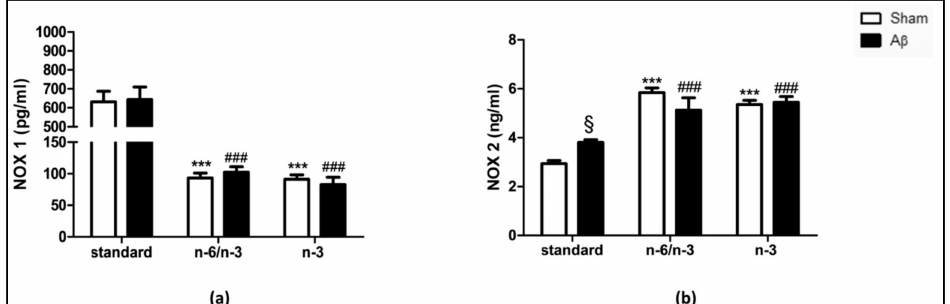
Figure 2. Effects of standard, n-6/n-3 PUFA balanced and n-3 PUFA enriched diets on NADPH oxidases (NOXs) expression in A β -treated rats. Effect of standard, n-6/n-3 PUFA balanced and n-3 PUFA enriched diets on hippocampal NOX1 ( a , SHAM standard n = 5, A β standard n = 8, SHAM n-6/n-3 n = 4, A β n-6/n-3 n = 3, SHAM n-3 n = 3, A β n-3 n = 3) and NOX2 ( b , SHAM standard n = 5, A β standard n = 8, SHAM n-6/n-3 n = 4, A β n-6/n-3 n = 4, SHAM n-3 n = 4, A β n-3 n = 4) expression in rats 7 days after A β icv injection (A β , 4 µ M, black bar) or vehicle (SHAM, 5 µ L, white bar). Two-way ANOVA followed by Bonferroni multiple comparison test, § p < 0.05 A β -treated rats fed with standard diet versus SHAM rats; *** p < 0.001 SHAM rats fed with n-6/n-3 balanced and n-3 PUFA enriched diets versus SHAM standard diet; ### p < 0.001, A β -treated rats fed with n-6/n-3 balanced and n-3 PUFA enriched diets versus A β standard diet. Data were expressed as means ± mean standard error